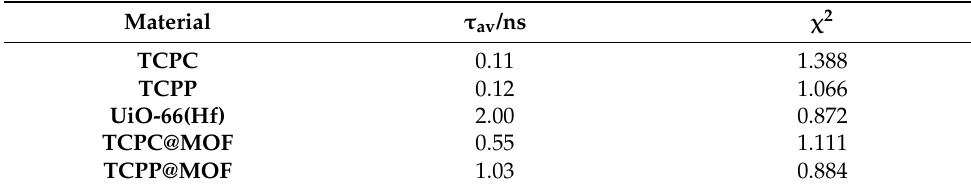
Table 2. PL lifetime and values obtained for TCPC, TCPP, UiO-66(Hf), TCPC@MOF and TCPP@MOF using the materials-embedded membranes.